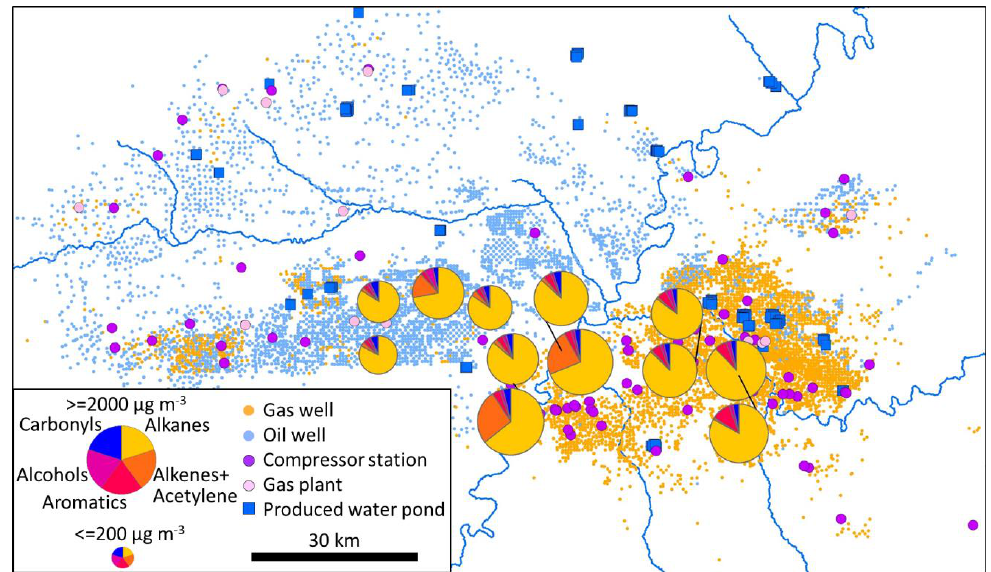
Figure 5. Composition (weight percent) and total concentration of organic compounds measured on 11 January 2020 from 10:00 to 16:00.